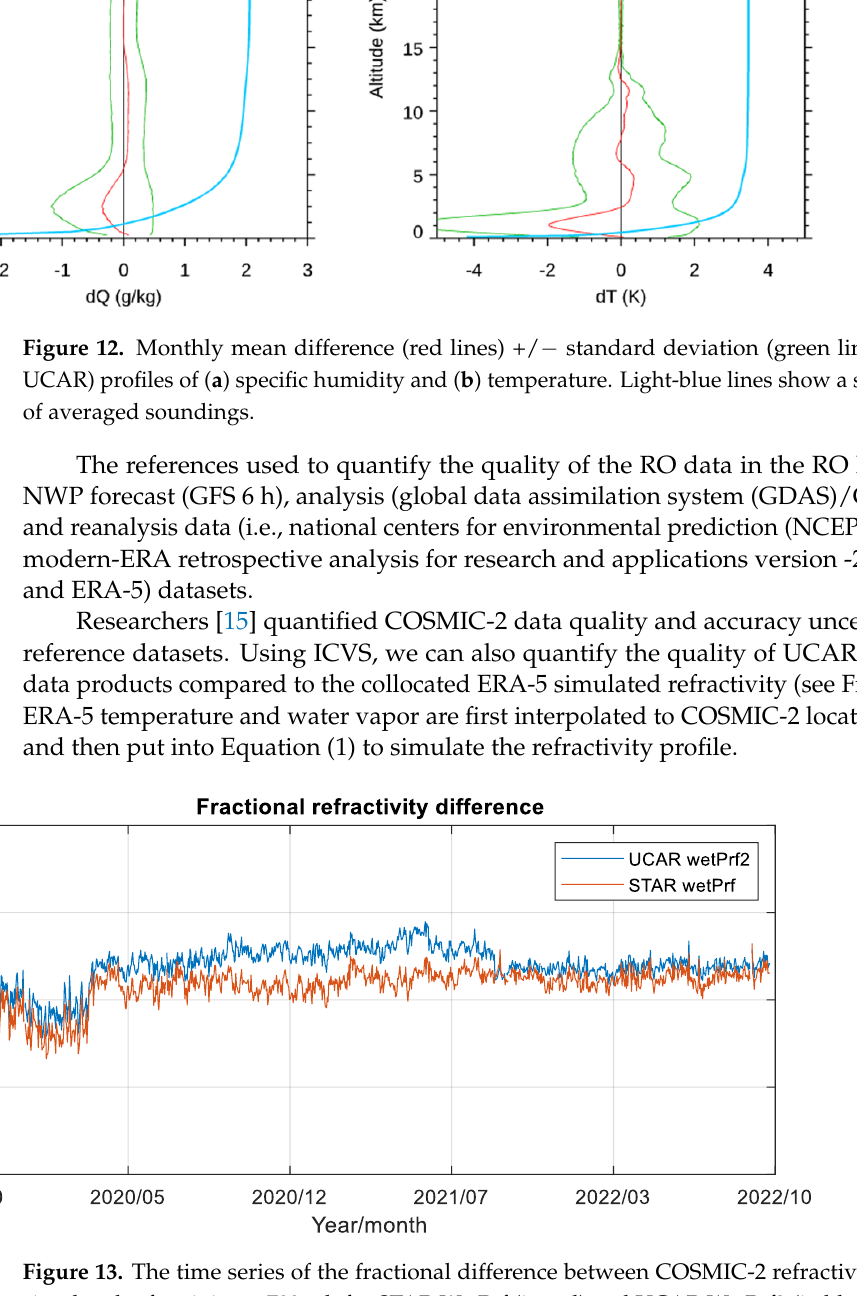
Figure 14. Similar to 13 but for COSMIC-2 and ERA-5 water vapor specific humidity mean differ- ence time series at 700 mb for STAR WetPrf (in red) and UCAR WetPrf2 (in blue). 5. Evaluation of STAR COSMIC-2 Wet Profile Retrievals through Comparison with CrIS and ATMS Above in situ comparisons are mainly over lands and islands over oceans. To extend the validation globally (from 45°N to 45°S), we compare the STAR-derived COSMIC-2 temperature and water vapor profiles with NOAA CrIS and ATMS measurements in this section. 5.1. Comparisons with CrIS Measurements Using CRTM and Double-Difference Method 5.1.1. Validation Approaches This section highlights COSMIC-2 multi-sensor calibration and validation studies conducted in STAR (see Figure 1). Here we evaluate COSMIC-2 STAR temperature and humidity retrievals (WetPrf) by comparing them with CrIS measurements using the com- munity radiative transfer model (CRTM) [45 – 47]. CRTM is a fast radiative transfer model for calculations of radiances for satellite IR or MW radiometers such as CrIS and ATMS and outputting IR/MW radiance and brightness temperatures at CrIS/ATMS ’ s spectral resolutions. In the section, the STAR COSMIC-2 1D-Var temperature and humidity pro- files are used as inputs for the CRTM for radiance/brightness temperature simulation (also see [36]).